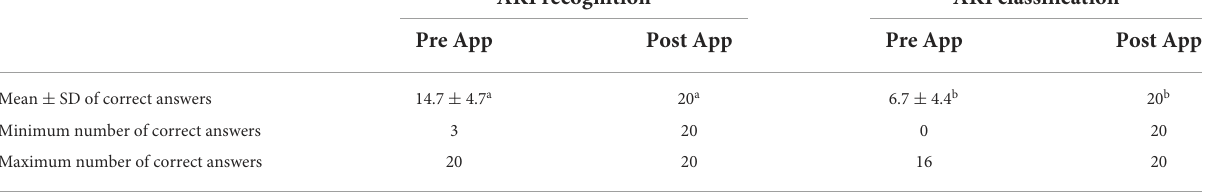
TABLE 2 AKI recognition and classification pre and post IRA-SLANH App